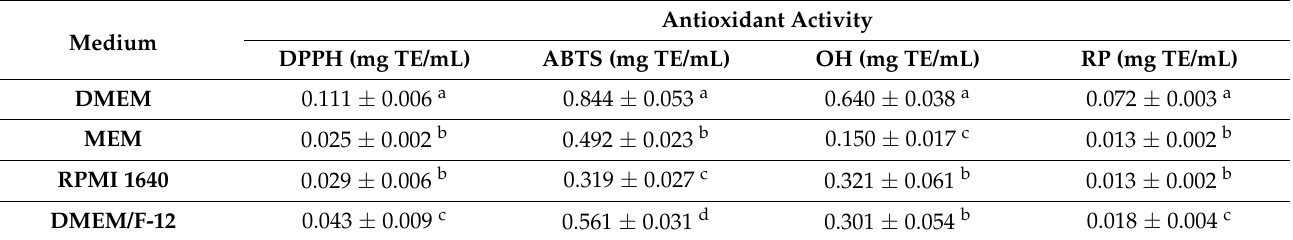
Table 1. Antioxidant properties of the cell culture